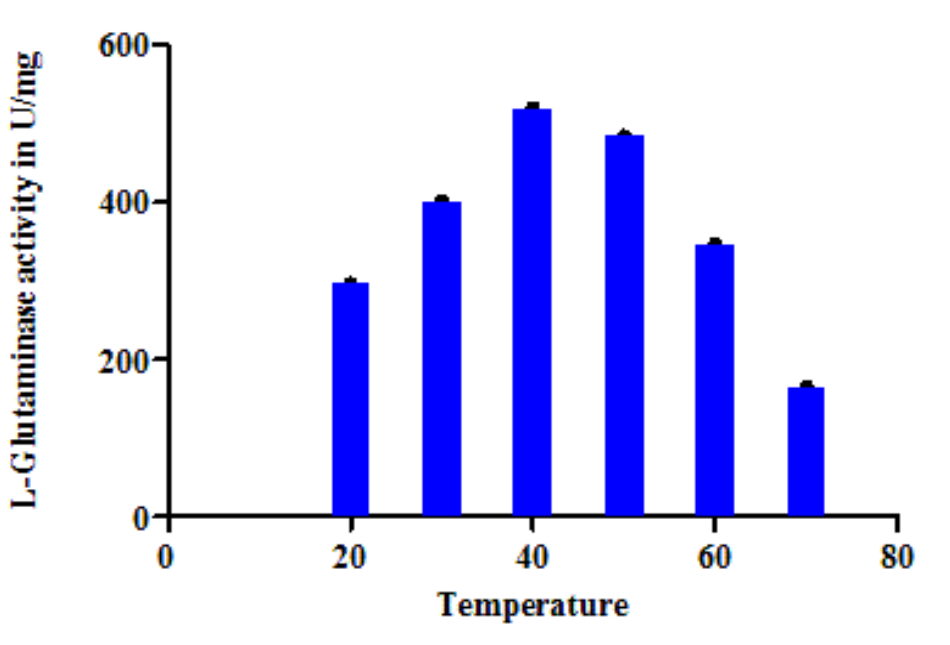
Figure 13. Effect of temperature on L-glutaminase activity produced by A. xylosoxidans RSHG1 at a pH of 7.